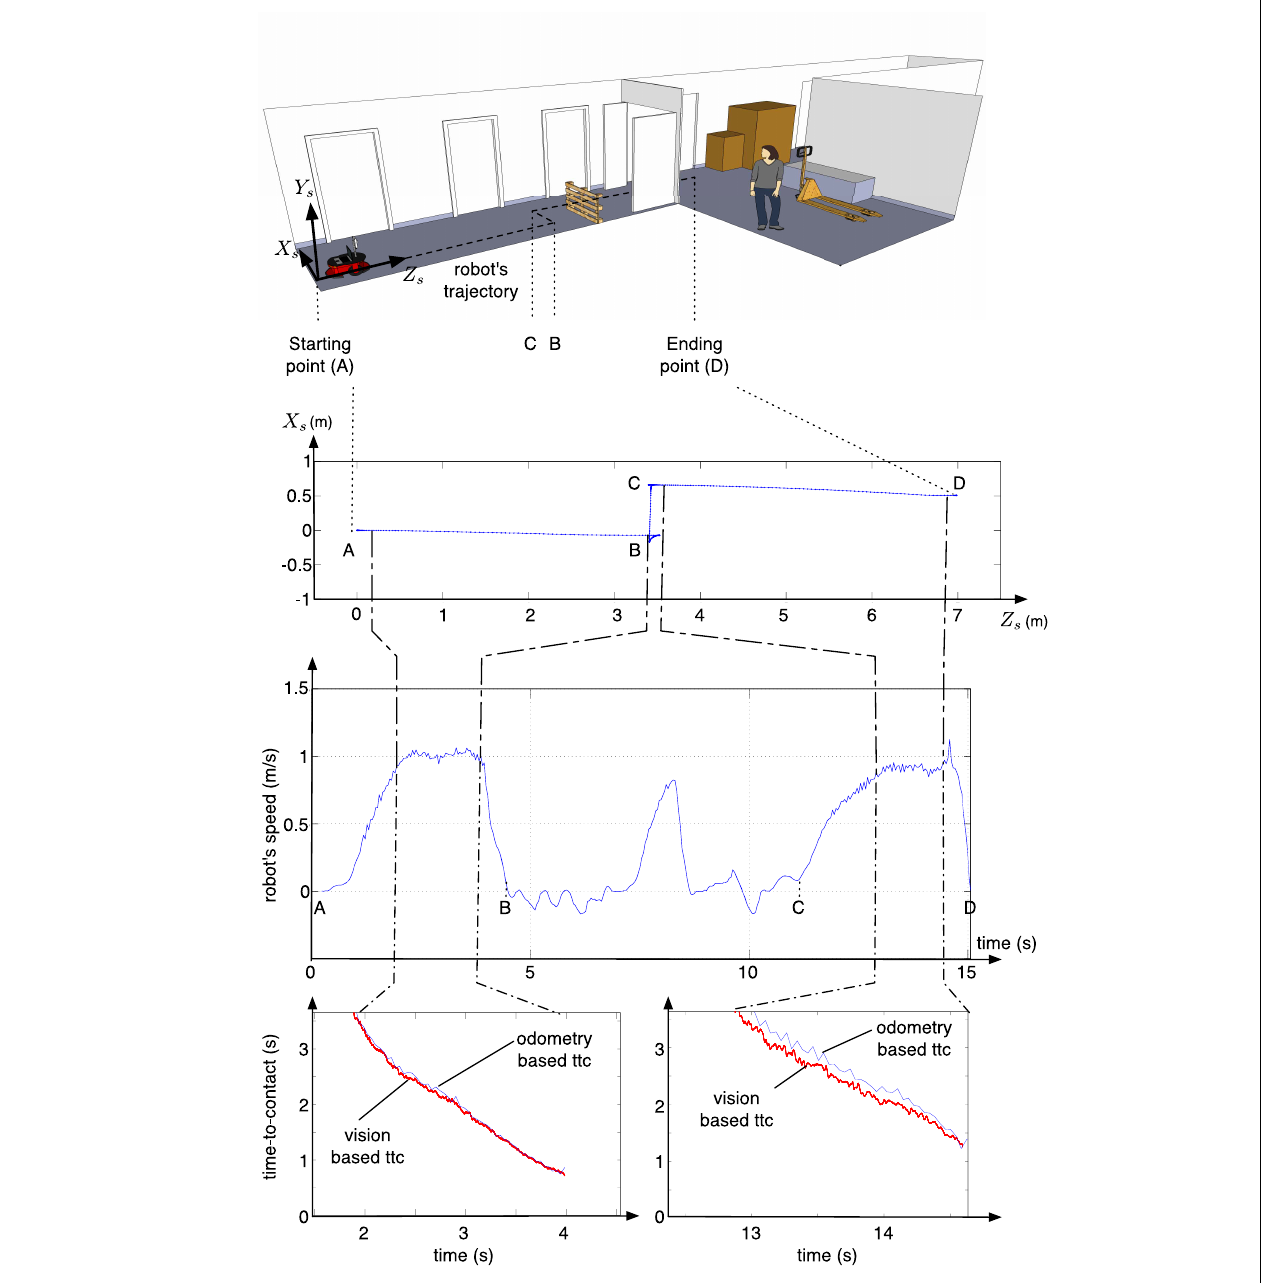
FIGURE 9 | Results of second experiment: the top Figure represents the trajectory followed by the the robot, on a schematic view of the warehouse, both middle Figures represents data collected from the odometer (the trajectory and the speed of the robot) and finally, the bottom Figures represent the time-to-contact estimated during the